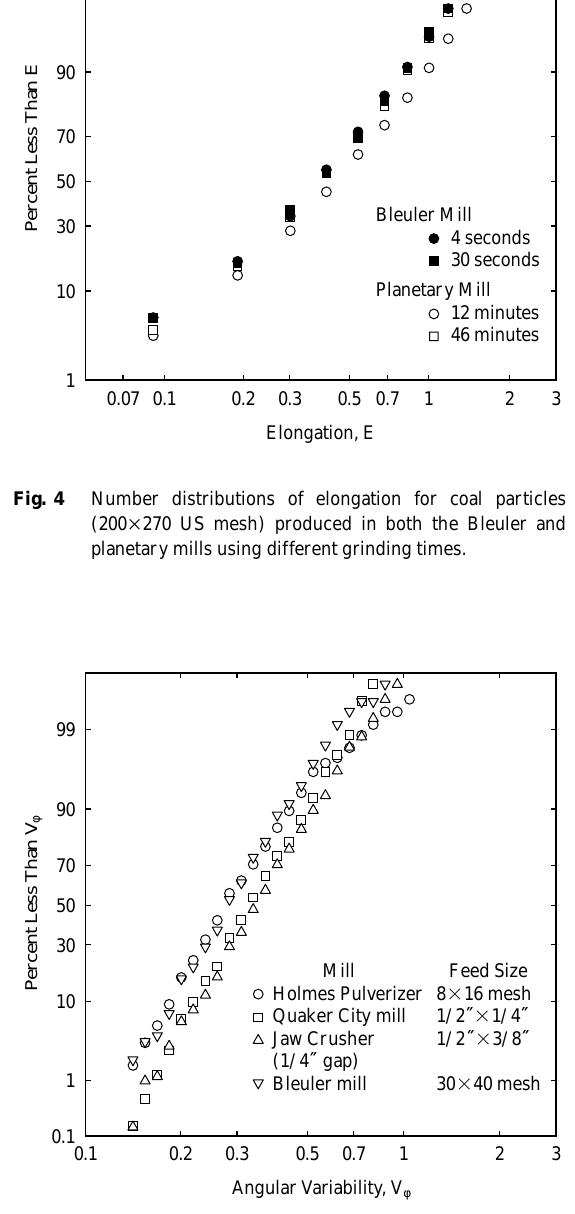
Number distributions of angular variability for coal parti- cles (70 (cid:7) 100 US mesh) produced by different comminu-